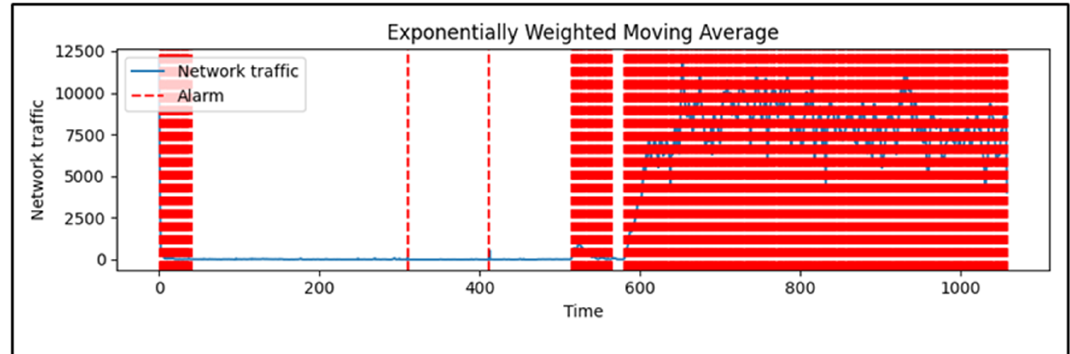
Figure 17. Flooding attack detection by EWMA.